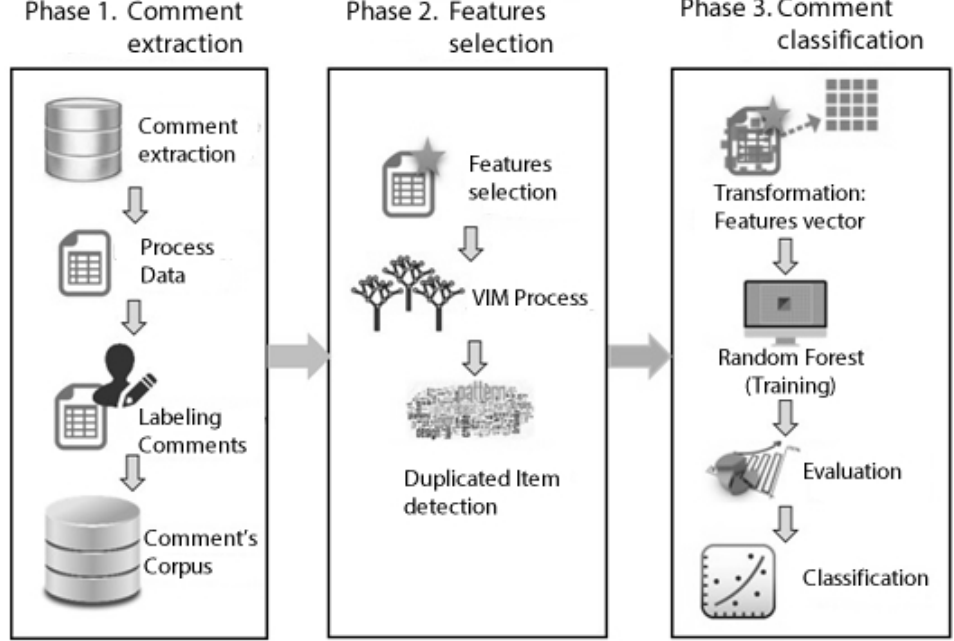
Figure 1. Architecture of the proposed computational model.